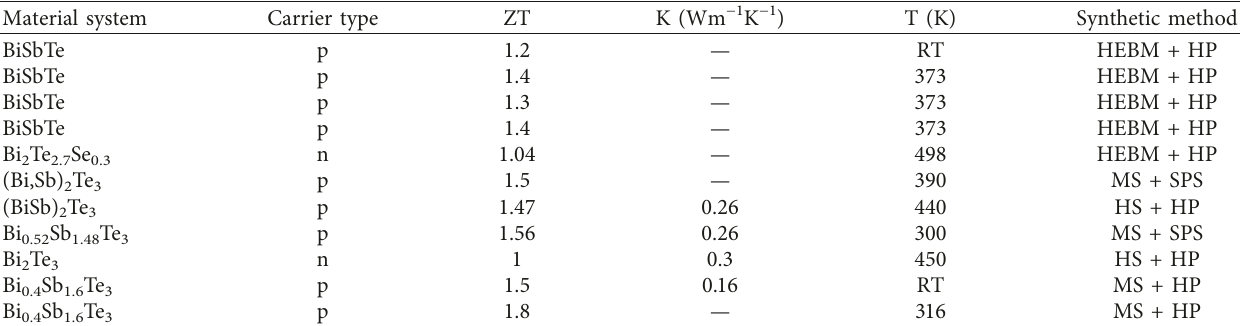
Table 2: Thermoelectric properties of low-dimensional and nanostructured materials synthesized by various synthetic methods in the past years (reproduced from [8] with